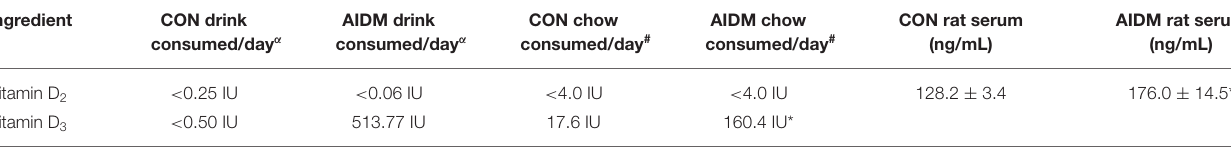
TABLE 2 | Vitamin D consumption, and resultant serum values after 30 days on CON or AIDM diets post-TBI. Ingredient